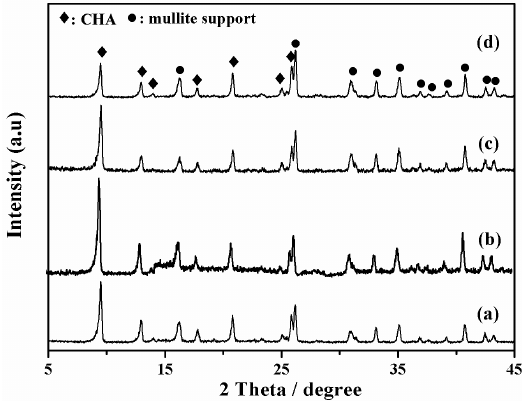
Figure 4. XRD patterns of high silica SSZ-13 zeolite membranes with different H 2 O/SiO 2 ratio, ( a ) M-4, H 2 O/SiO 2 = 20; ( b ) M-5, H 2 O/SiO 2 = 40; ( c ) M-6, H 2 O/SiO 2 = 60; ( d , b ) M-3, H 2 O/SiO 2 = 80.